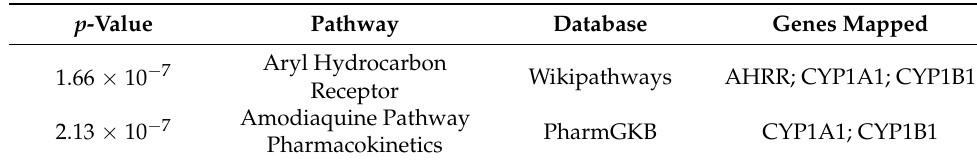
Table 2. Most significant pathways are shown. Additionally, CYP1A1 and CYP1B1 are significantly